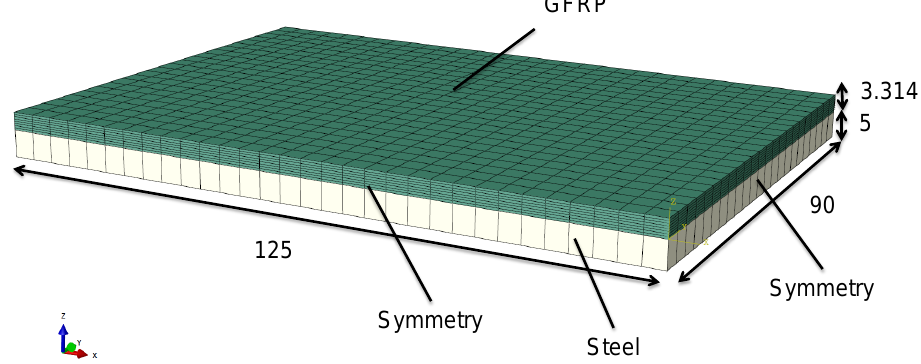
Figure 10. FE-Model of